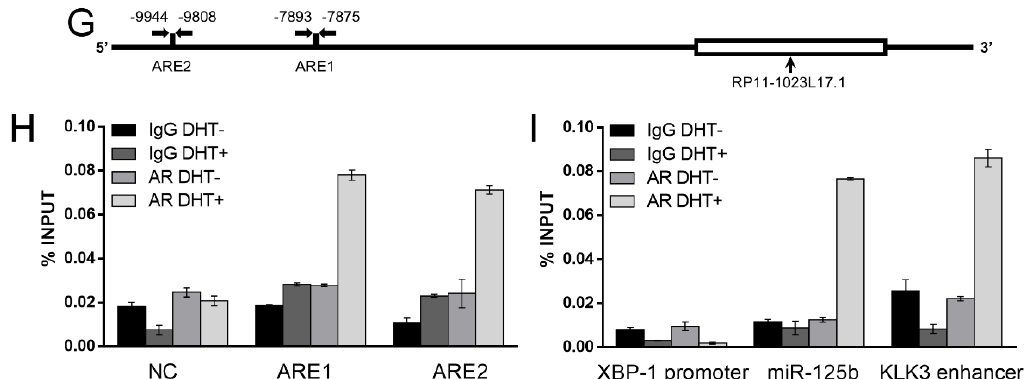
Figure 1. Androgen responsive lncRNA RP11-1023L17.1 is a direct AR target. ( A - D ) LNCaP cells were treated with 10 nM DHT (DHT+) or ethanol (DHT − ) for 0, 2, 8, 24, and 48 h, or with 0, 0.1, 1, 10, 100, and 1000 nM DHT for 24 h. Expression levels of lncRNA RP11-1023L17.1 (A and B) and KLK3 (positive control, C , D ) were evaluated by RT-qPCR. ( E , F ) The expression levels of AR in LNCaP cells were knocked down using small interfering RNAs si-AR 544 and si-AR 357. RT-qPCR was used to measure the expression changes of AR and RP11-1023L17.1 under normal ( E ) or androgen deprivation ( F ) con- ditions. KLK3 was used as a positive control. ( G ) Illustration of the potential ARE sites (ARE1: 7875– 7893 bp upstream and ARE2: 9808–9944 bp upstream) located within the 10-kb region upstream of the RP11-1023L17.1 transcription start site (TSS). ( H , I ) ChIP-PCR analysis of LNCaP cells treated with 100 nM DHT (DHT+) or ethanol (DHT − ). Cell lysates were immunoprecipitated with control IgG or AR